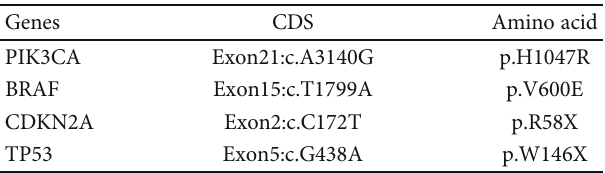
Figure 1: HE and IHC of histopathology. Histopathology of biopsy of the breast. (a) and (b) show HE staining. Poorly di ff erentiated malignant cells invading stromal areas. (c) shows an IHC positive for AE1/3, which rules out sarcoma. (d) – (f) show negative IHCs for GATA3, SOX100, and S100. These results exclude malignant Table 1: The result of NGS.